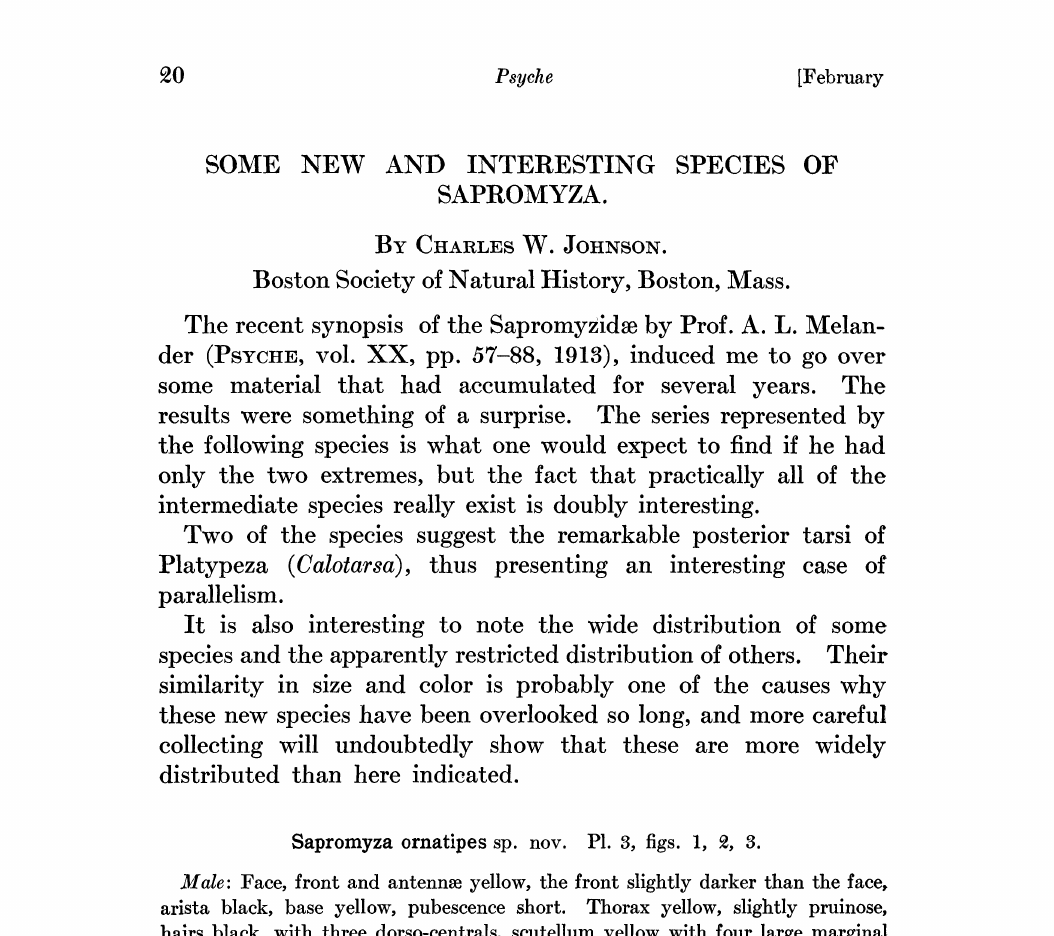
arista black, base yellow, pubescence short. Thorax yellow, slightly pruinose, hairs black, with three dorso-centrals, scutellum yellow with four large marginal bristles. Abdomen dark yellow, ttalteres and legs light yellow, posterior tarsi whitish, metatarsi with a row of short black bristles along the outer side and two long, curved, black subapical bristles slightly broader and flattened at the ends, the two following joints as broad as they are long, black, base white, thickly covered with black hairs and with two long curved bristles on each, similar to those on the meiatarsi, the remaining joints brownish at the tips, with small black bristles and hairs. Wings hyaline, clouded with brown, the latter starting near the junction of the second and third veins and extending to a little beyond the anterior cross vein and along the costa from near the end of the first to the end of the fourth vein, with a partial interruption just beyond the end of the second vein, a band also extending across the wing covering the posterior cross vein. Length 3.5 ram. Female similar to the male except that the posterior tarsi are not differentiated, although the second and third joints are